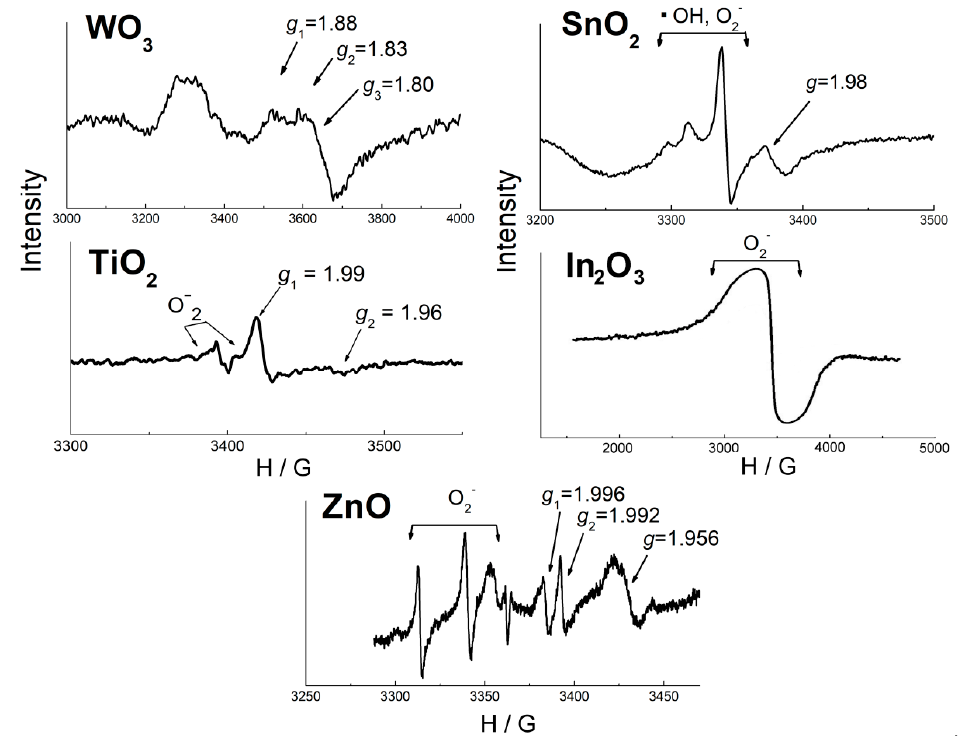
Figure 13. EPR spectra of nanocrystalline n -type MOS. Adapted with permissions from ref. [79] copyright 2014 American Chemical Society; ref. [95] copyright 2013 American Chemical Society; ref. [96] copyright 2021 Springer Nature; ref. [101] copyright by the authors; ref. [102] copyright 2013 Elsevier.